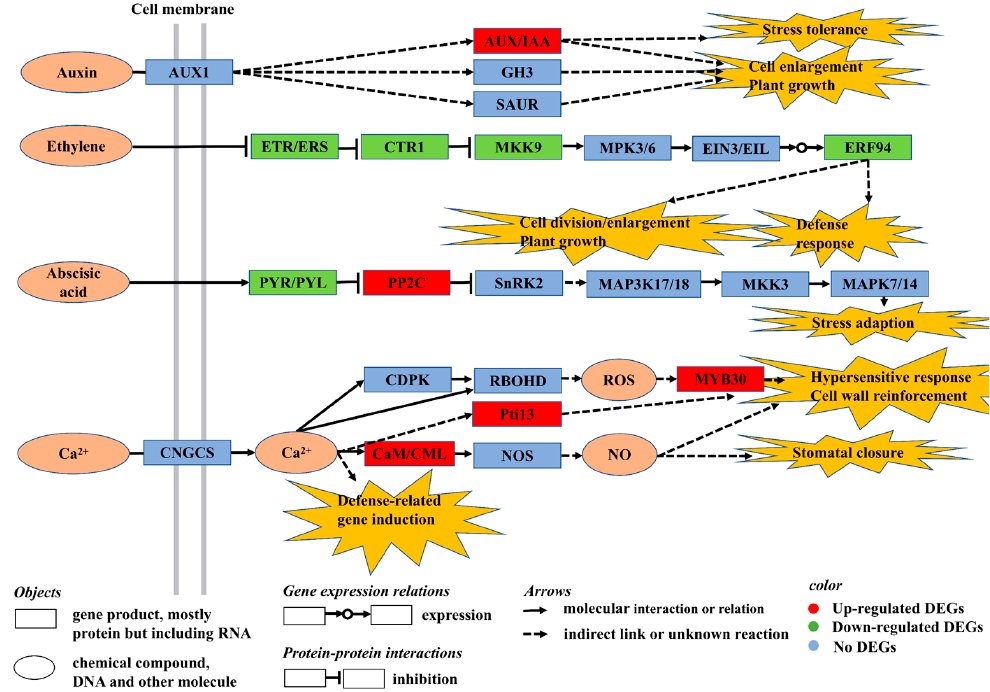
Figure 10. Metabolism and signaling pathway map. Abbreviations: AUX1 , auxin transporter-like protein; AUX/IAA , auxin-responsive protein IAA; GH3 , indole-3-acetic acid-amido synthetase GH3; SAUR , auxin-responsive protein SAUR ; ETR/ ERS , ethylene receptor 1; CTR1 , MAPKKK serine/threonine-protein kinase CTR1; MKK9 , mitogen-activated protein kinase kinase 9; MPK3/6 , mitogen-activated protein kinase 3/6; EIN3/EIL , ethylene-insensitive 3-like 3 protein; ERF94 , ethylene-responsive transcription factor 94; PYR/PYL , abscisic acid receptor PYR/PYL; PP2C , protein phosphatase 2C; SnRK2 , serine/threonine-protein kinase SRK2; MAP3K17/18 , mitogen-activated protein kinase kinase kinase 17/18; MKK3 , mitogen-activated protein kinase kinase 3; MAPK7/14 , mitogen-activated protein kinase 7/14; CDPK , calcium-dependent protein kinase; RBOHD , respiratory burst oxidase homolog D; CNGCS , cyclic nucleotide-gated ion channel; CaM/CML , calmodulin and calmodulin-like protein; NOS , NO-associated protein 1; Pti13, PTI1-like tyrosine protein kinase 3; and MYB30, transcription factor MYB30. The signaling components indicated by the boxes filled with the red color were up-regulated by VDAL, whereas those denoted by the boxes filled with the green color were down-regulated by VDAL. The signaling components indicated by the boxes filled with the light blue color were not affected by VDAL.